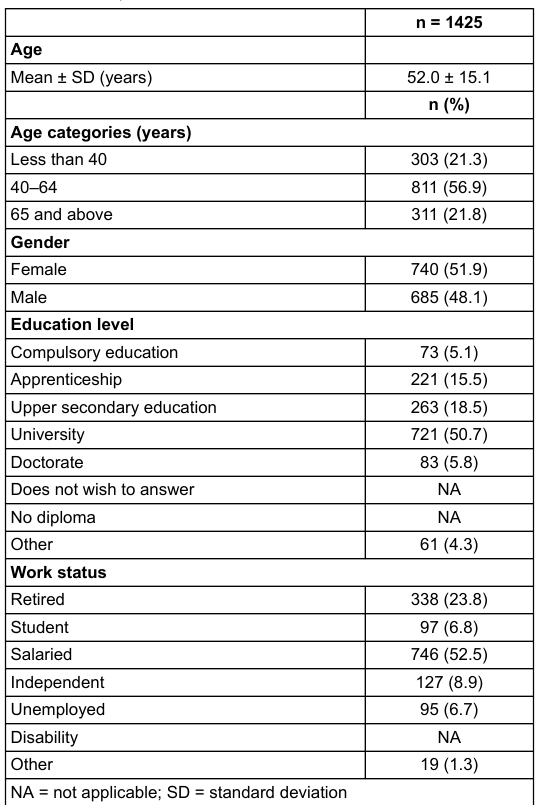
Table 1: Participant characteristics.